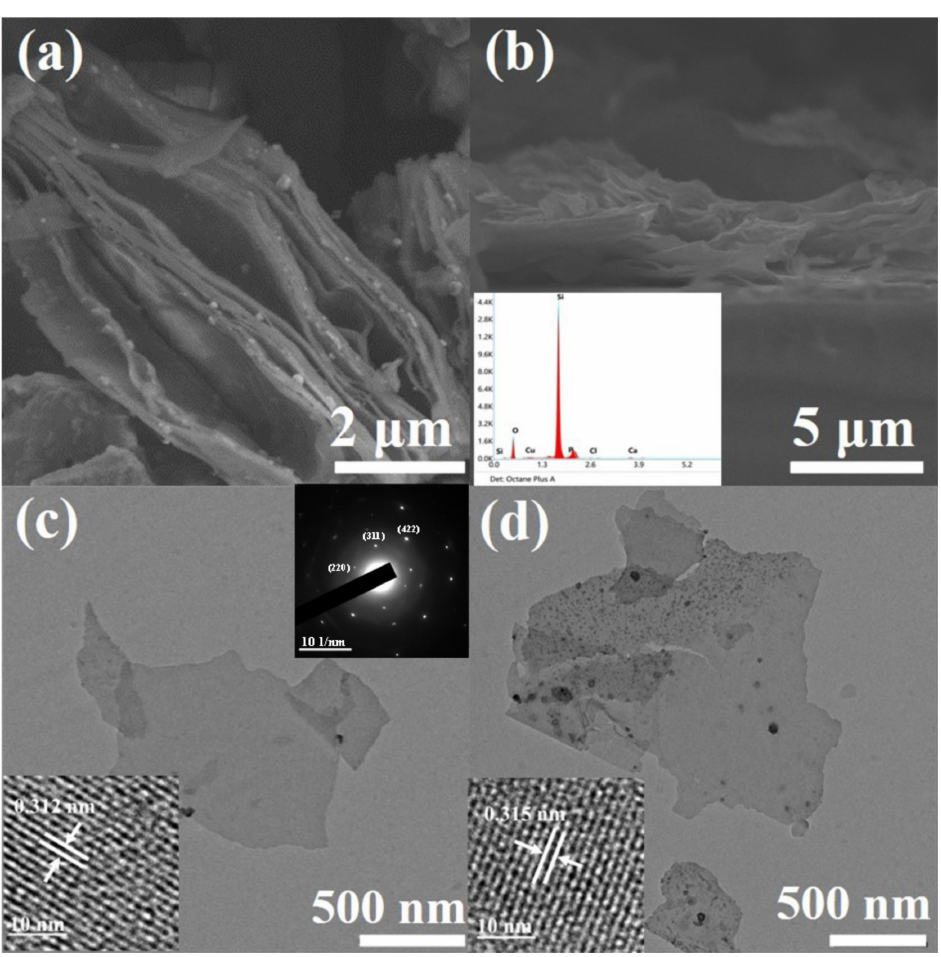
Figure 2. Scanning electron microscope (SEM) and transmission electron microscope (TEM) images of silicon nanosheets. ( a ) Top-view image of undoped layered silicon nanosheets; ( b ) cross-section image of doped layered silicon nanosheets with energy dispersive spectroscopy (EDS) as inset; ( c ) TEM image of undoped dispersive silicon nanosheets with high resolution transmission electron microscope (HRTEM) image and selected area electron diffraction (SAED) pattern as insets; ( d ) TEM image of doped dispersive silicon nanosheets with HRTEM image as